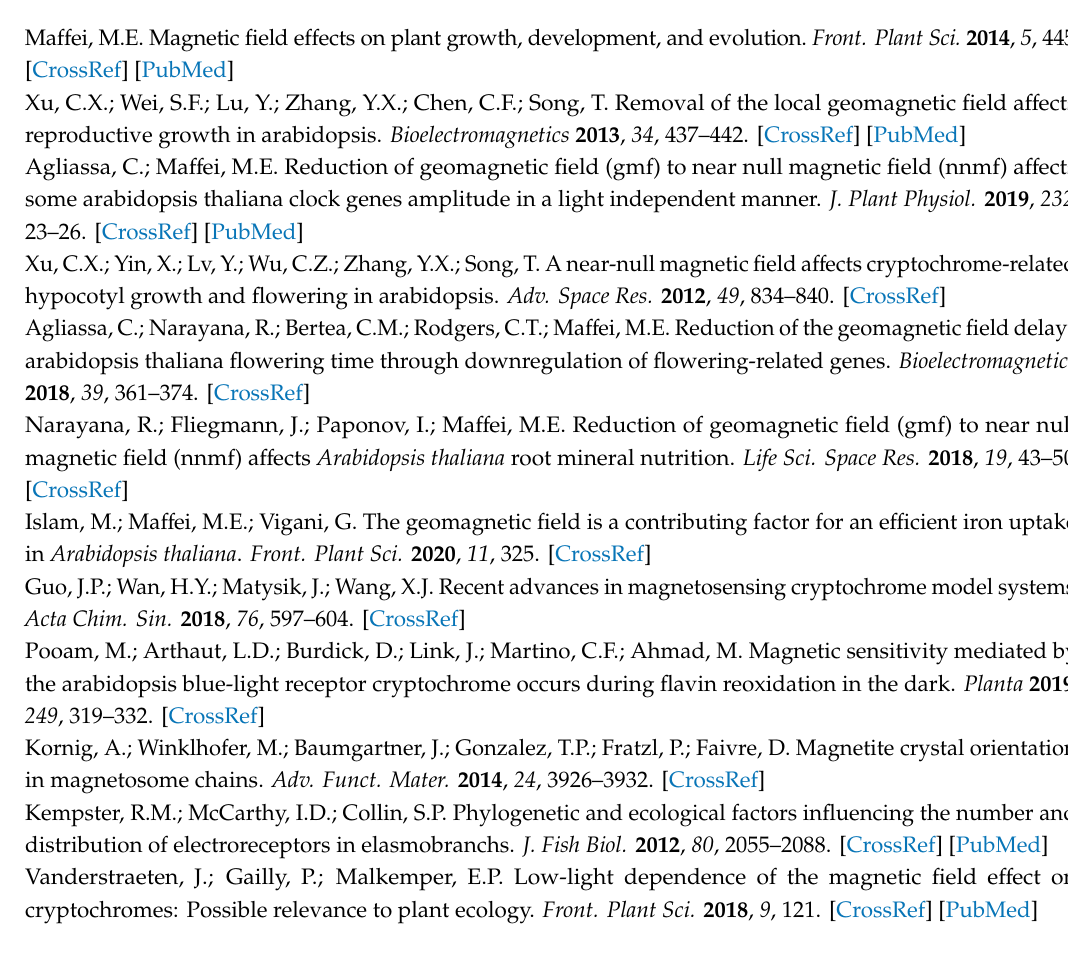
Table S1: Direct comparison of morphological and developmental parameters between Arabidopsis thaliana exposed to either GMF or NNMF, Table S2: primers used in qPCR analyses. Figure S1, time couse exposure of Arabidopsis to NNMF and GMF